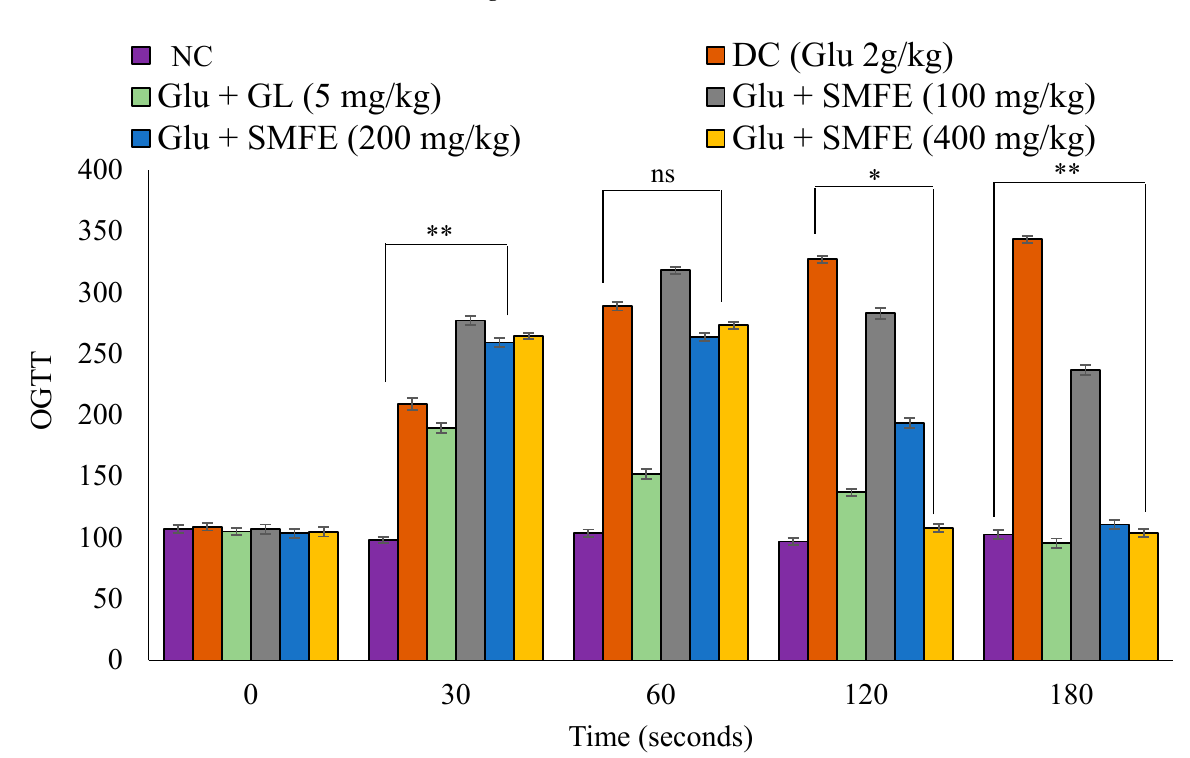
Figure 7. Effects of SMF extract on oral glucose tolerance test in mice. Data are represented as the mean ± SEM ( n = 6). ** p < 0.01 = significant when compared with diabetic control group normal mice. * p < 0.05 = significant when compared with diabetic control. ns p > 0.05 = non-significant when compared with diabetic control. NC = normal control; SMFE = S. mangifera fruit extract; OGTT = oral glucose tolerance test; Gl = glibenclamide; Glu = glucose; DC = diabetes control.